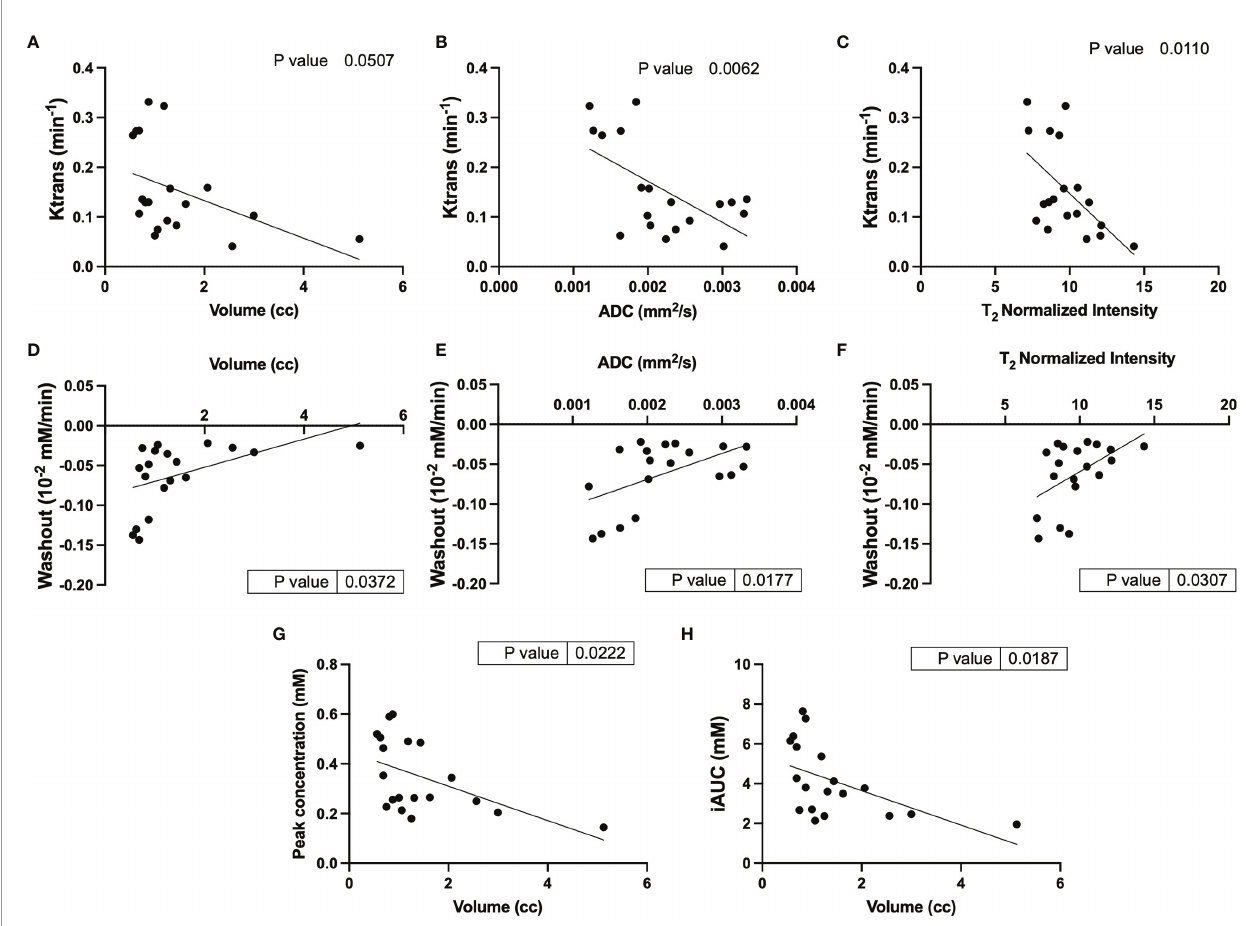
FIGURE 4 | Correlational analysis of quantitative and semi-quantitative DCE parameters and physiological parameters. Correlation of Ktrans with (A) volume, (B) ADC and (C) T2 normalized intensity; Washout correlated to (D) volume, (E) ADC and (F) T2 normalized intensity; and volume correlation with (G) peak concentration and (H)